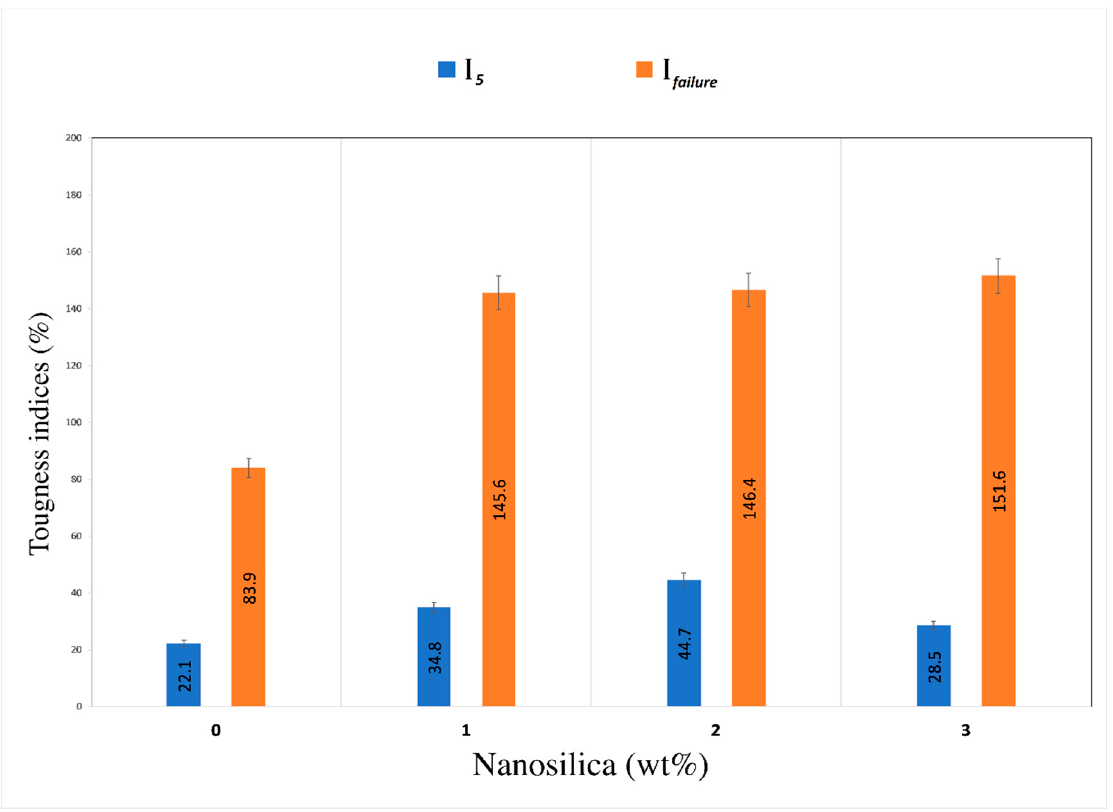
Figure 5. Toughness indices of composites.